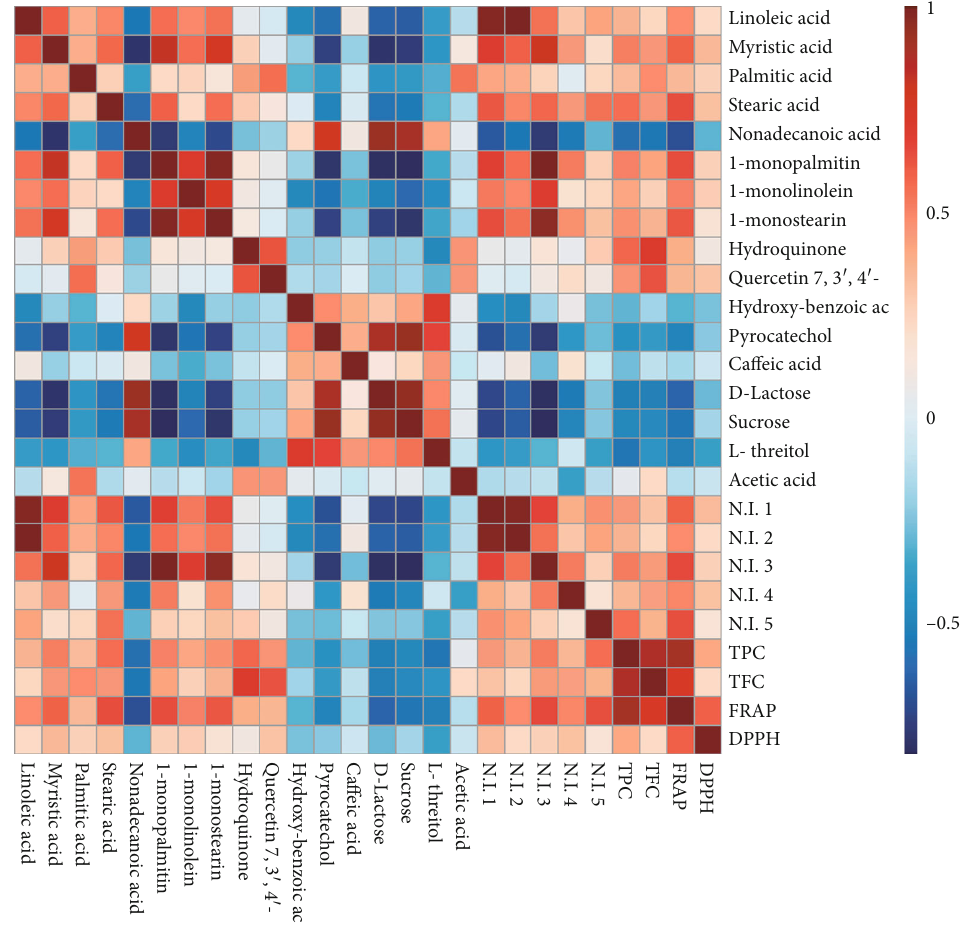
Figure 3: Correlation patterns among metabolites and antioxidant activity (DPPH, FRAP, TPC, and TFC). Each square indicates Pearson ’ s correlation coe ffi cient of a pair of metabolites and antioxidant activity. Red color represents positive correlation ( 0 < r < 1 ) and blue color represents negative correlation ( − 1 < r < 0